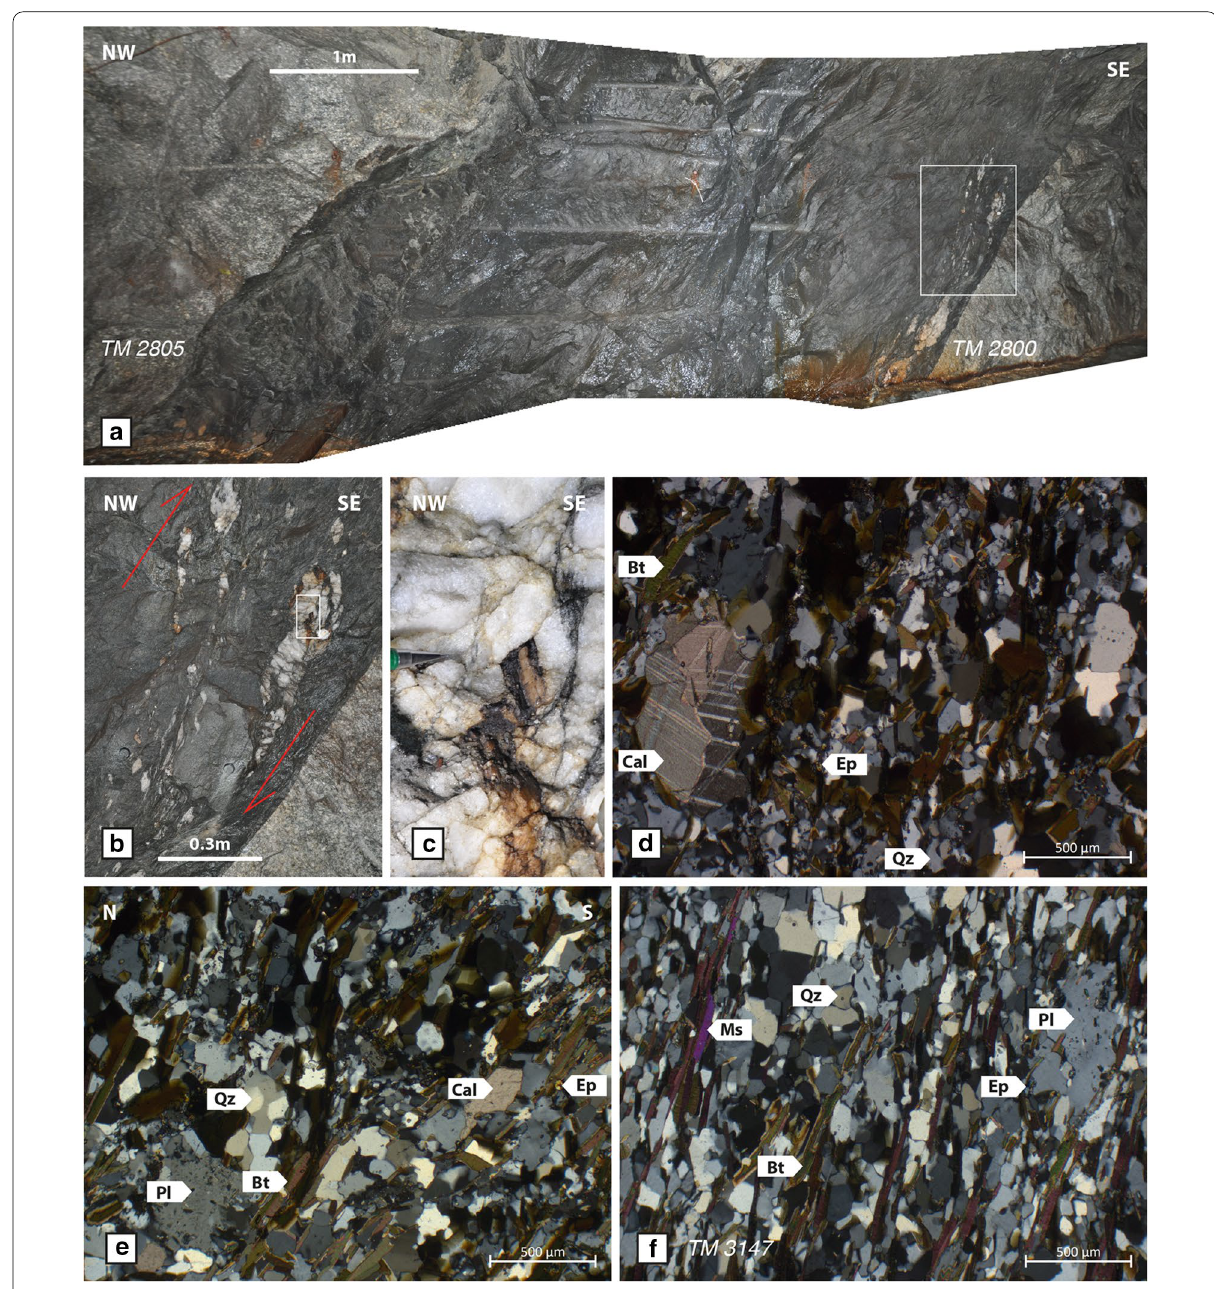
Fig. 11 Field photographs and photomicrographs of the QB-SZ between TM 2800 and TM 2805 ( a – e ) and at TM 3147 ( f ). a White frame indicates the close-up shown in ( b ). b Close-up of the SE-contact. Shear sense is indicated by sigmoidal quartz veins. White frame indicates a further close-up shown in ( c ). c Rigid calcite crystals (brown) inside deformed quartz (white), pencil tip for scale. d , e Photomicrographs of the QB-SZ between TM 2800 and TM 2805, crossed polarized light. f Photomicrograph of a QB-SZ at TM 3147, crossed polarized